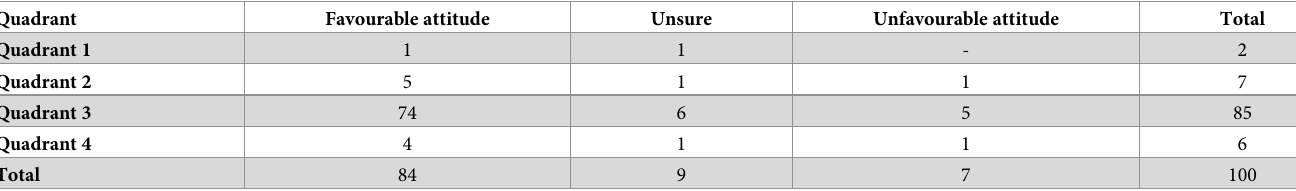
Table 3. I 3 mapping for